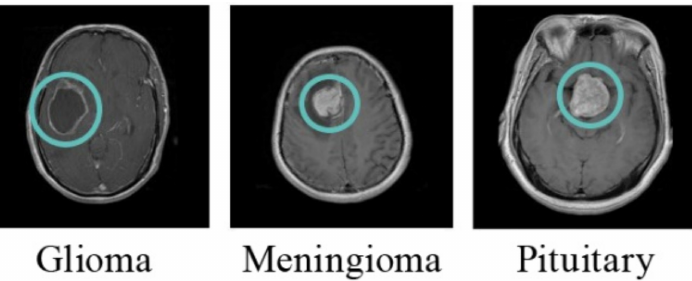
Figure 1. The most common forms of brain tumor (the tumors are localized inside a green circle).